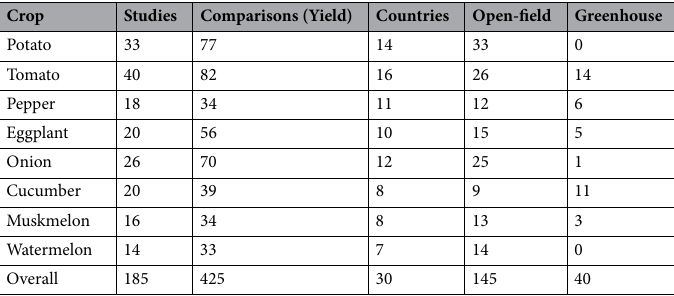
Table 1. Overview of data included in the